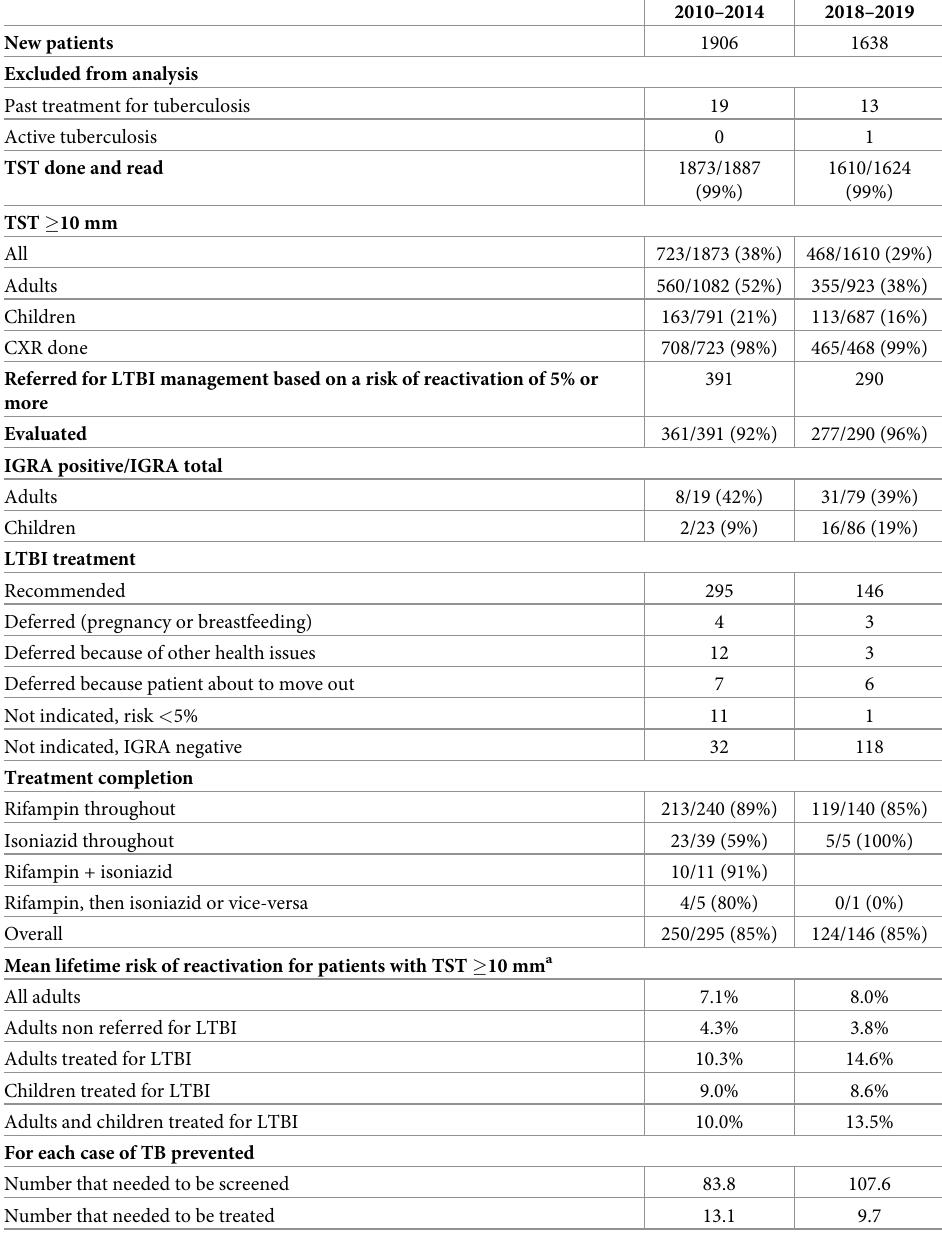
Table 3. Pathway of refugees evaluated for latent tuberculosis